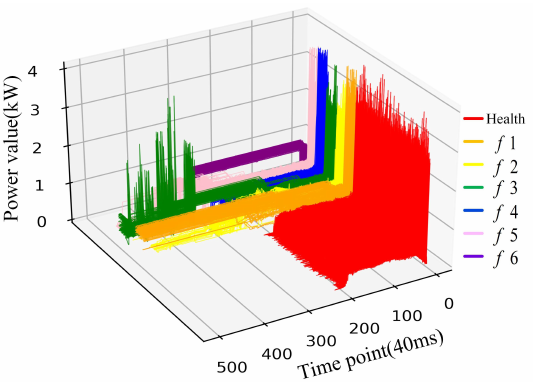
Figure 6. The power curve dataset selected for the experiment.